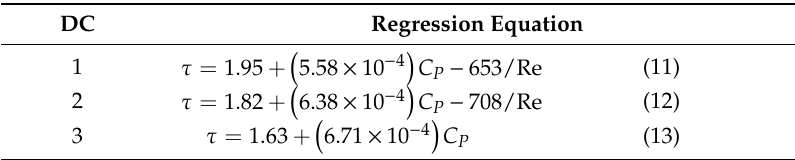
Table 10. Simple models identified by the regression